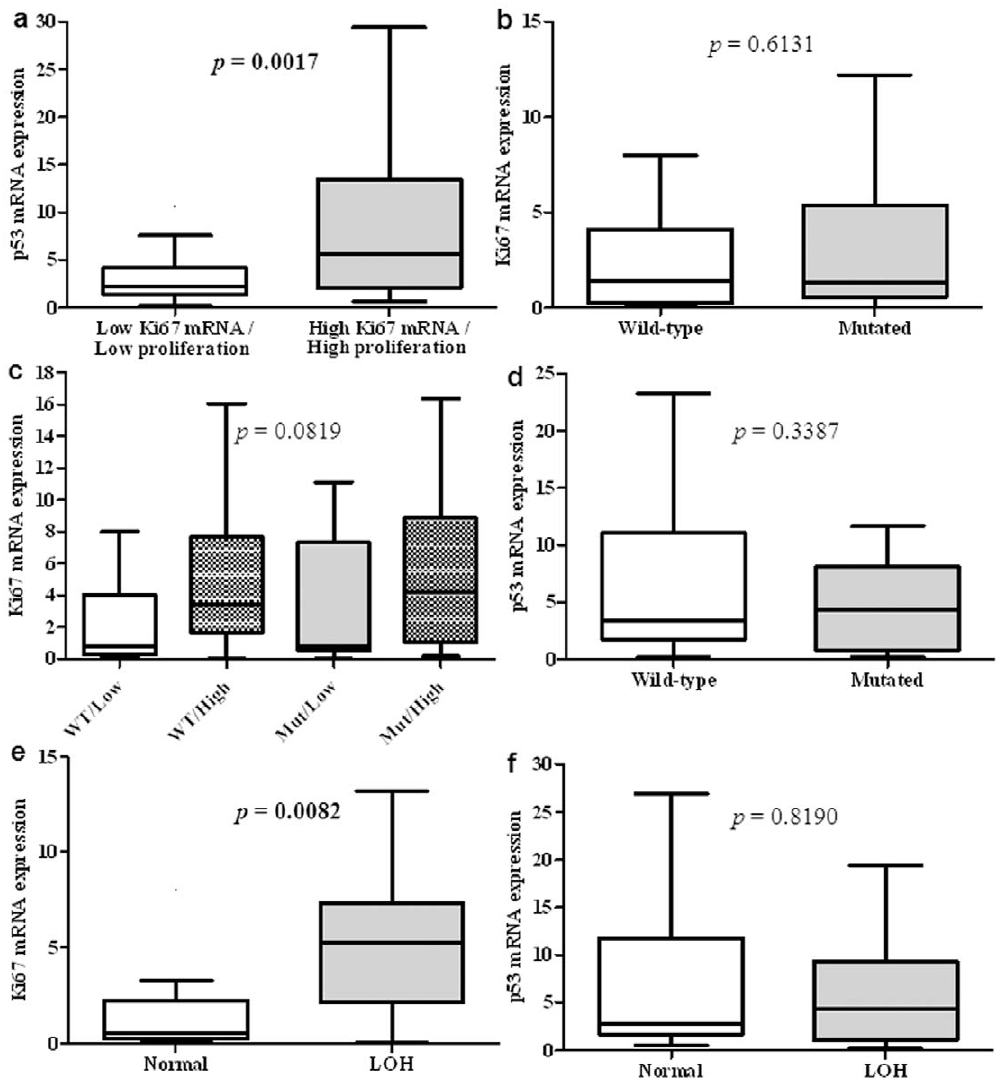
Figure 1. Correlations with proliferation status of tumours. a. Box plot corresponding to p53 mRNA expression depending on proliferation status. b. Box plot corresponding to proliferation rate depending on TP53 mutation status. c. Box plot corresponding to proliferation rate depending on TP53 mutation status coupled with level of p53 mRNA expression. d. Box plot corresponding to proliferation rate depending on LOH in 17p13. e. Box plot corresponding to p53 mRNA expression depending on TP53 mutation status. f. Box plot corresponding to p53 mRNA expression depending on LOH in 17p13. p , 0.05 was considered significant.